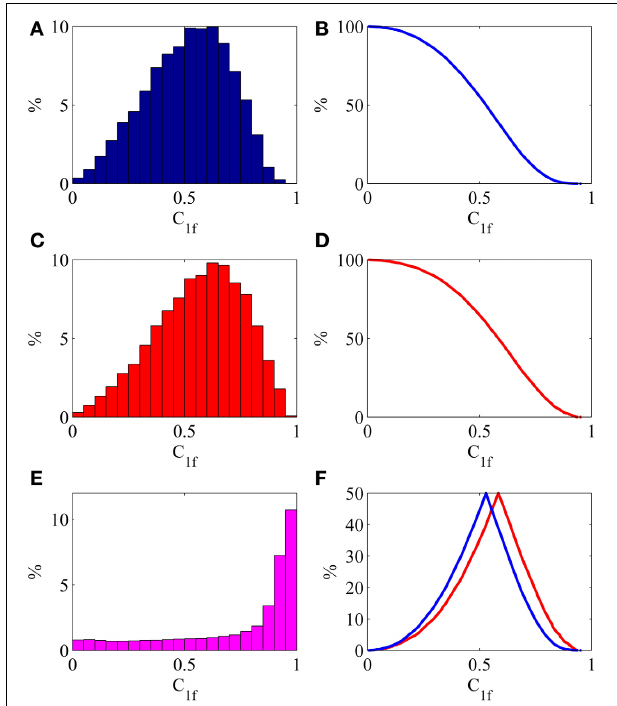
FIGURE 5 | Statistical properties of the restored oscillations. C 1 f —one frequency empirical coherence (6). (A) Shows relative number of frequencies, falling in the 5%-bin of coherence. (B) Shows share of frequencies, having coherence greater than chosen value. (C) Shows relative summary energy of frequencies, falling in the 5%-bin of coherence. (D) Shows share of common energy, produced by frequencies, having coherence greater than chosen value. (E) Shows distribution of the relative one-frequency energy, falling in the 5%-bin of coherence. For example, average energy, produced by one frequency with coherence > 0.95, is 11 times greater than average energy, produced by one frequency. (F) Shows folded cumulated distribution functions, calculated from (B) blue and (D)